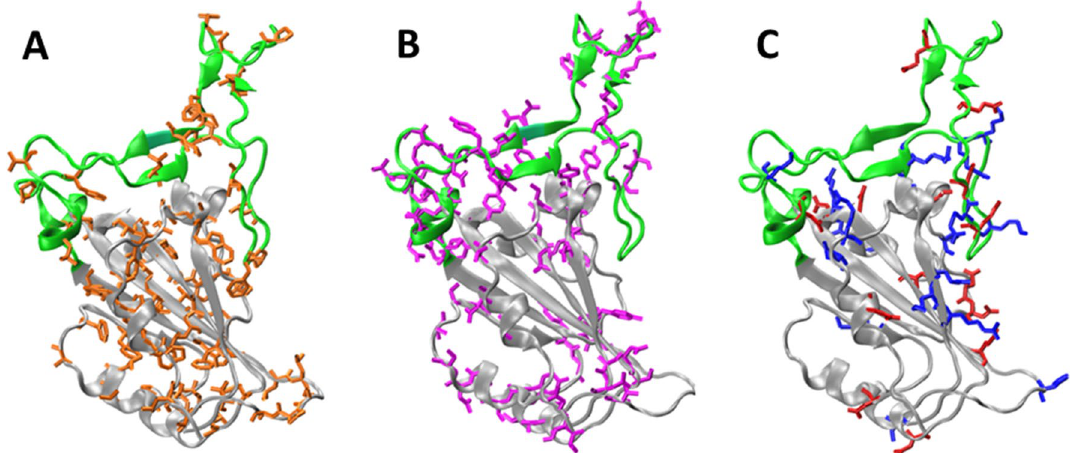
Figure 8. Subdomains and distribution of residue types on RBD. The Core (gray) and the RBM (green) regions are shown. Panels A, B, and C, shows the non-polar residues (orange: A, C, G, I, L, M, F, P, W and V), polar (violet: N, Q, S, T and Y), and charged residues (blue: basic K, R and H, red: acid D and E), respectively. To build the models we used the chain E of pdb structure 6m0j. Ionic pair interactions—distance in Å (accessible surface area, ASA, ratio